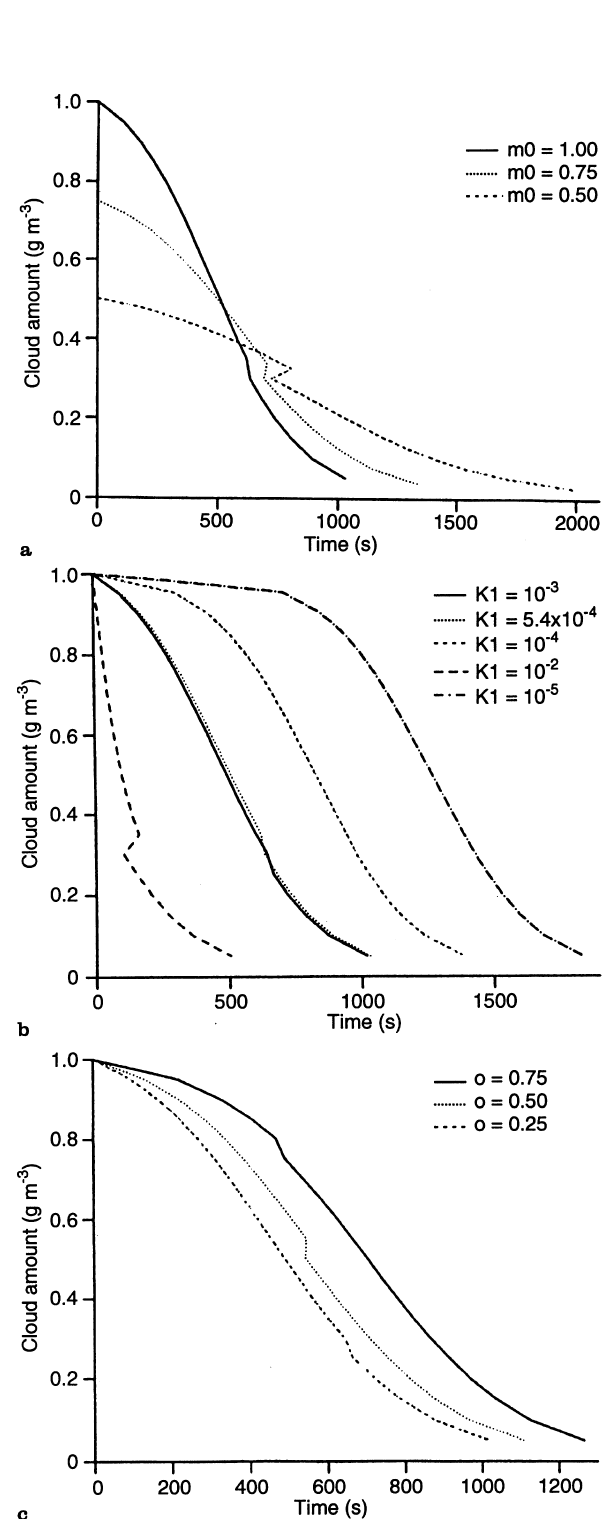
Fig. 2a–c. Time of onset of precipitation calculated from the analytical solutions of Eqs. (9) and (11) using the Kessler (1969) scheme. a E(cid:128)ect of varying initial cloud water content with fixed autoconversion coe(cid:129)cient and threshold. b E(cid:128)ect of varying autoconversion coe(cid:129)cient with fixed initial cloud water content and autoconversion threshold. c E(cid:128)ect of varying autoconversion threshold with fixed initial cloud water content and